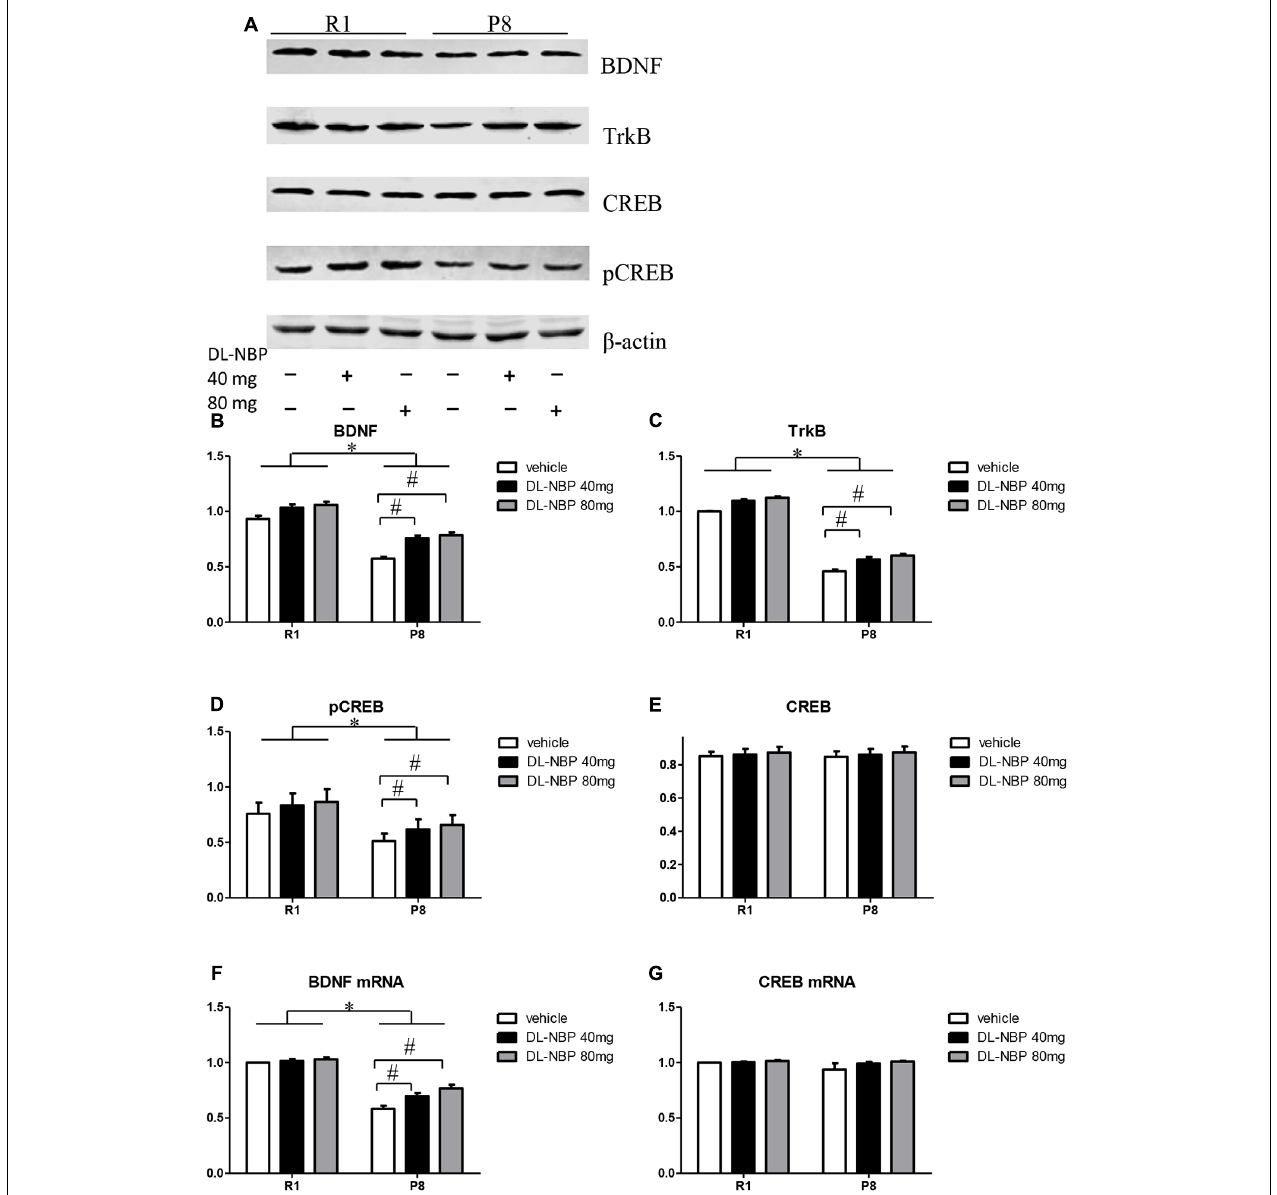
FIGURE 5 | Effects of DL-3- n -butylphthalide (DL-NBP) treatment on brain-derived neurotrophic factor (BDNF)/tropomyosin receptor kinase B (TrkB) signaling in the hippocampus of SAMP8 mice. (A–E) Representative western blot images of BDNF, TrkB, cAMP-response-element-binding protein (CREB), and phosphorylated CREB (pCREB). (F,G) BDNF and CREB mRNA levels evaluated by real-time PCR. Values were normalized to β -actin and the mRNAs were expressed as a percentage of the SAMR1 vehicle-treated samples. Data are presented as the mean ± standard error of the mean (SEM). ∗ p < 0.01 versus R1 group, # p < 0.01 versus P8 vehicle group. R1, SAMR1 mice; P8, SAMP8 mice ( n =